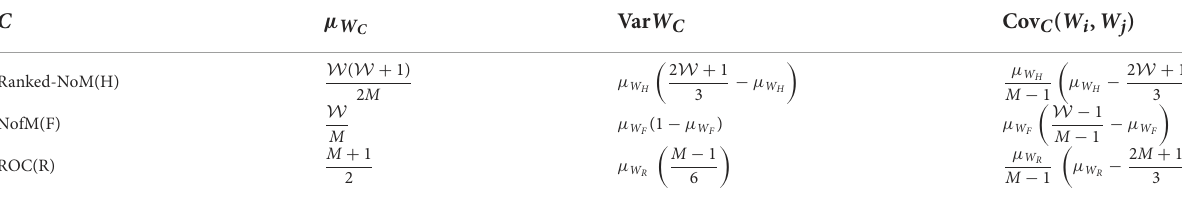
TABLE 2 Formulas for the expectation, variance and covariance of the scores random variable W for each scheme.